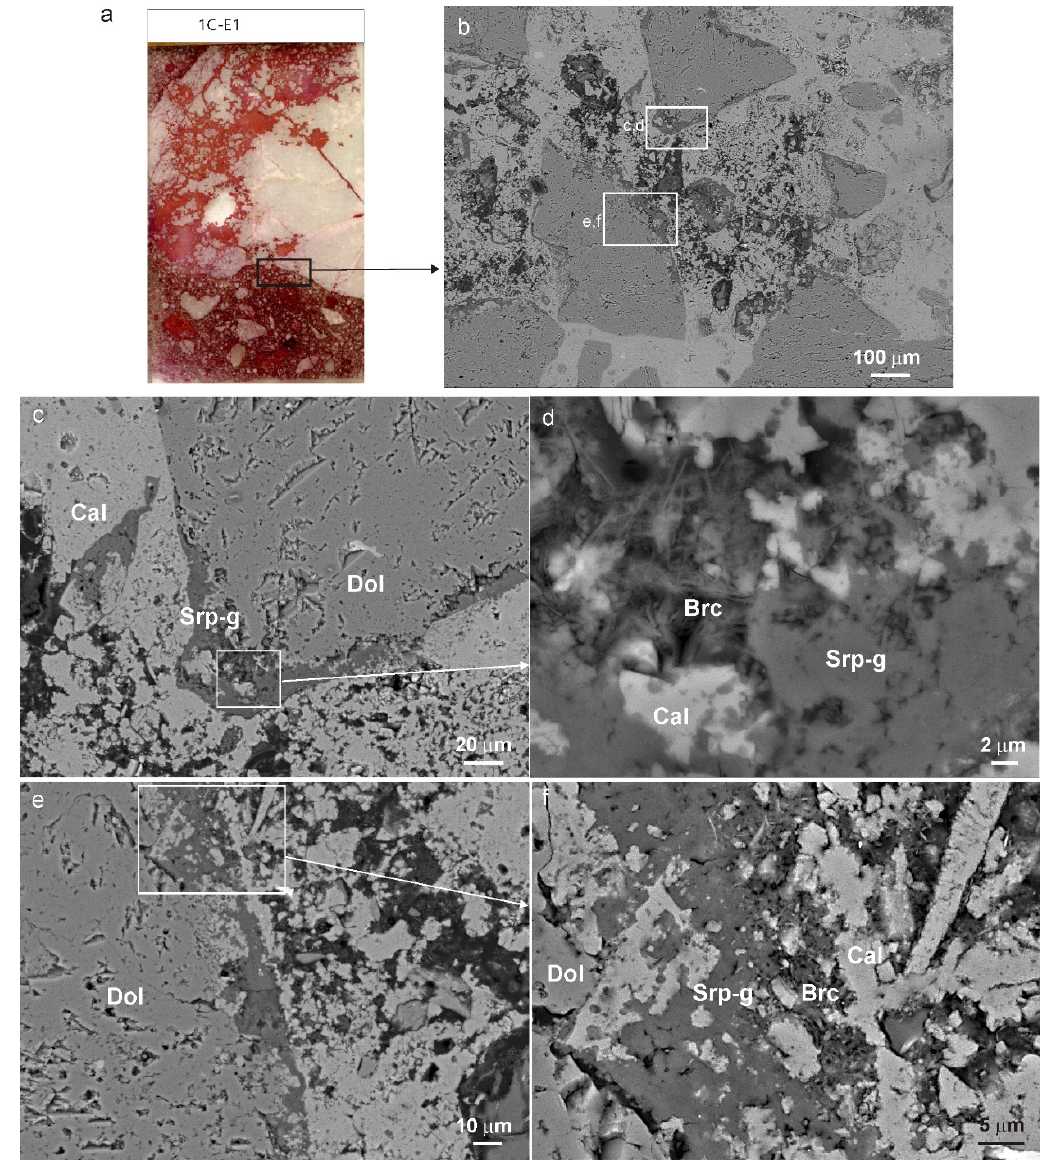
Figure 7. (a ) Image of a thin section of type A concrete stained with red alizarin, where calcite is red stained and dolomite is not stained. ( b ) BSC-SEM Image of two selected zones with aggregate dolomite particles showing grey rims of reaction between aggregate particles and cement paste; ( c ) Zoom of the rim on top ( c,d ) with the mineral phases identified by SEM-EDS, dolomite (dol), calcite (Cal), serpentine group mineral (Srp-g); ( d ) zoom of the image c, brucite (Brc) is detected by SEM-EDS forming radial aggregates of fibrous crystals or elongated crystals maximum 6 µm; ( e,f ) Zoom of other rim of dolomite, where elongated brucite crystals appears in contact with a cryptocrystalline serpentine-group mineral and calcite crystals with irregular borders.